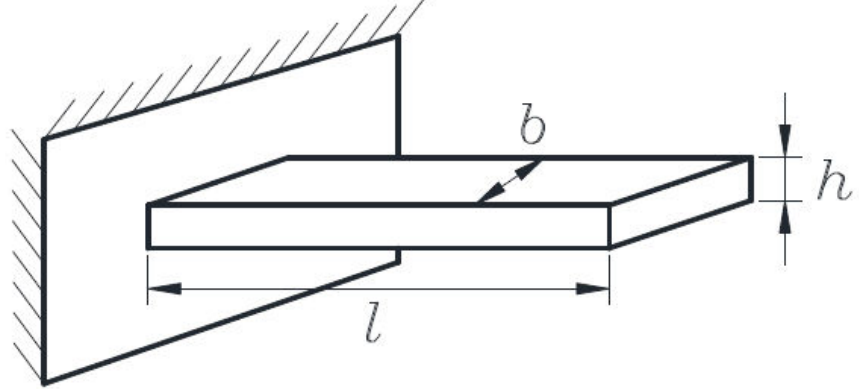
Figure 3. Dimensions of leaf